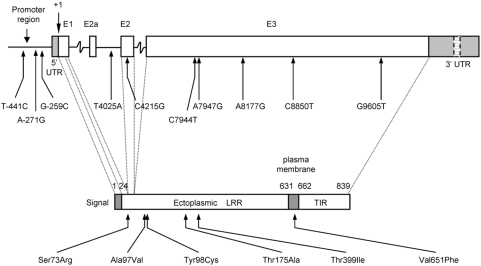
The positions of the TLR4 polymorphisms in the genomic sequence and the polypeptide sequence.Three polymorphisms were identified in the upstream region (T-441C, A-271G, G-259C), one in intron 2 (T4025A), one in exon 2 (C4215G), and five in exon 3 (C7944T, A7947G, A8177G, C8850T, G9605T). E1, E2, E3, E2a, represent exons 1, 2, 3 and the alternative exon 2. Transcriptional site indicated as +1. 6 exonic polymorphisms cause a change in amino acid residue, with 5 in the ectoplasmic domain and 1 in the plasma membrane domain. LRR denotes; leucine rich repeat. TIR denotes; Toll/IL-1R domain.